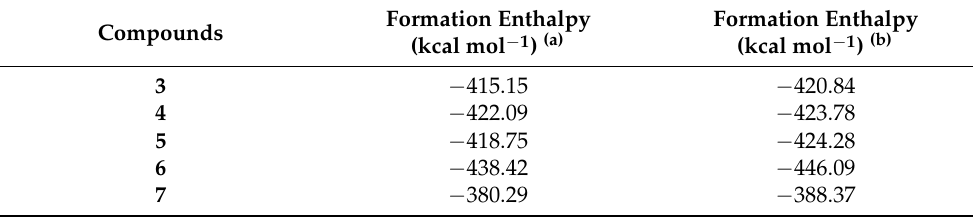
Table 1. Calculations of the formation enthalpies for compounds 4 – 7 * and precursor 3 .